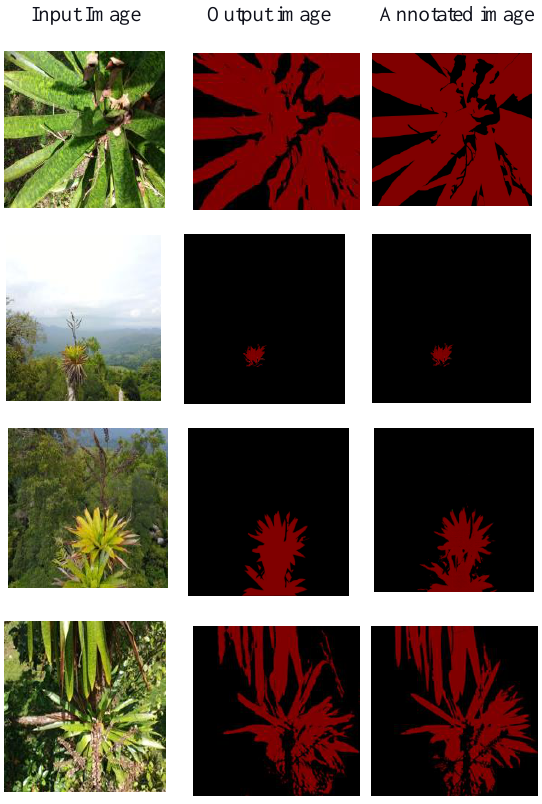
Figure 7. Output images generated by C-GAN (middle column) and the analyst annotated images (right column). These outputs were generated after the C-GAN algorithm was trained with 90% of the drone acquired images.